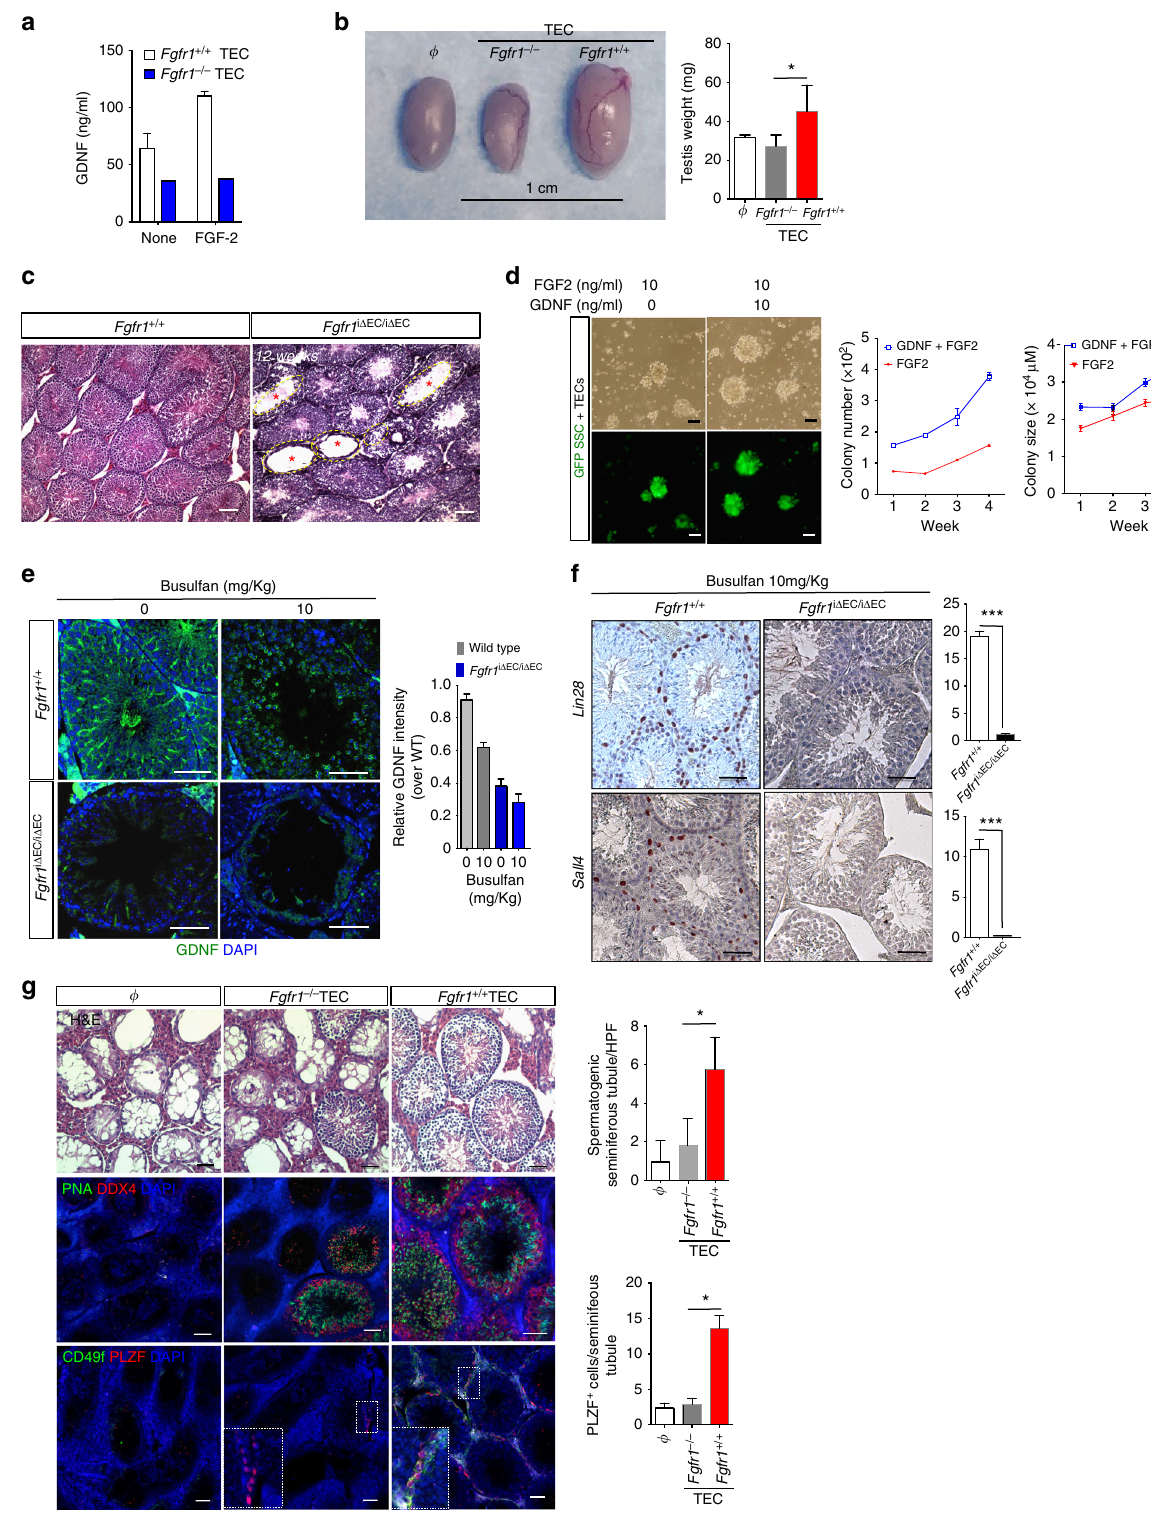
chromosome 21-encoded inhibitors of CaN – NFAT signaling 20 . Other studies show that males with DS have signi fi cantly reduced sperm counts and are either subfertile or infertile 21,22 . The Ts65Dn DS mouse model with segmental human trisomy has many features of DS including male infertility 41,42 . An almost